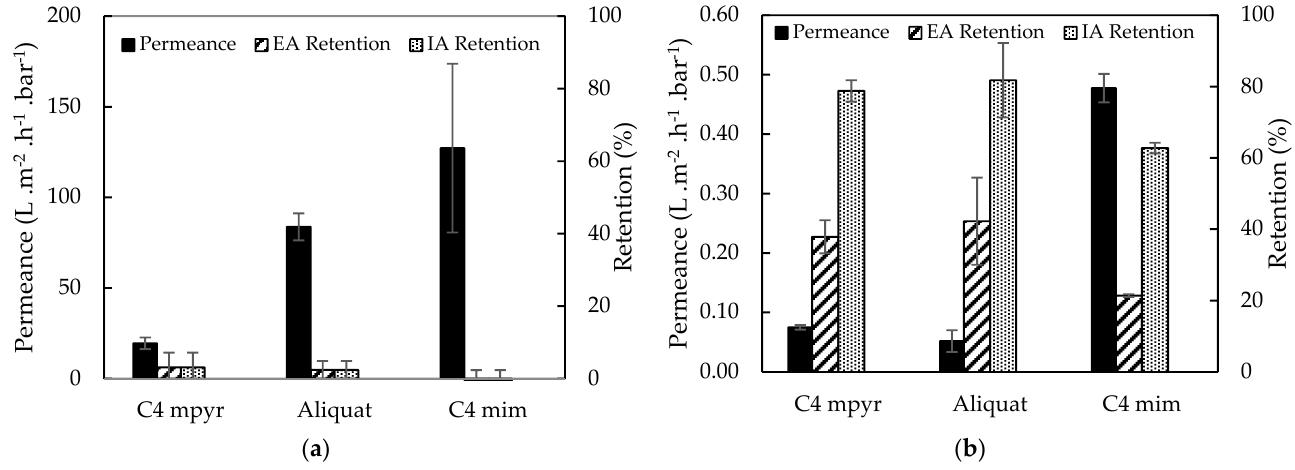
Figure 5. Water/EtOH permeance, EA and IA retentions of TFC membranes synthesized from different ILs as organic phase on ( a ) PSf and ( b ) XL-PI support. With C4 mpyr for [ C 4 mpyr ][ Tf 2 N ] and C4 mim for [ C 4 mim ][ Tf 2 N ].